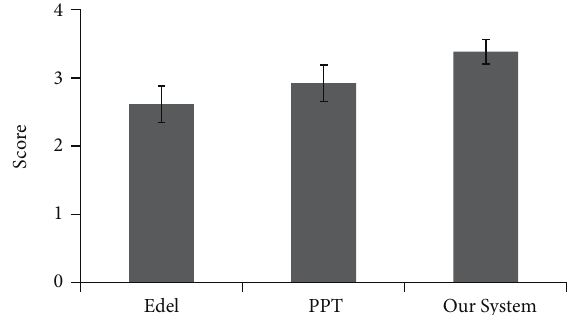
Figure 18: Results for Q6: the average and standard error for each